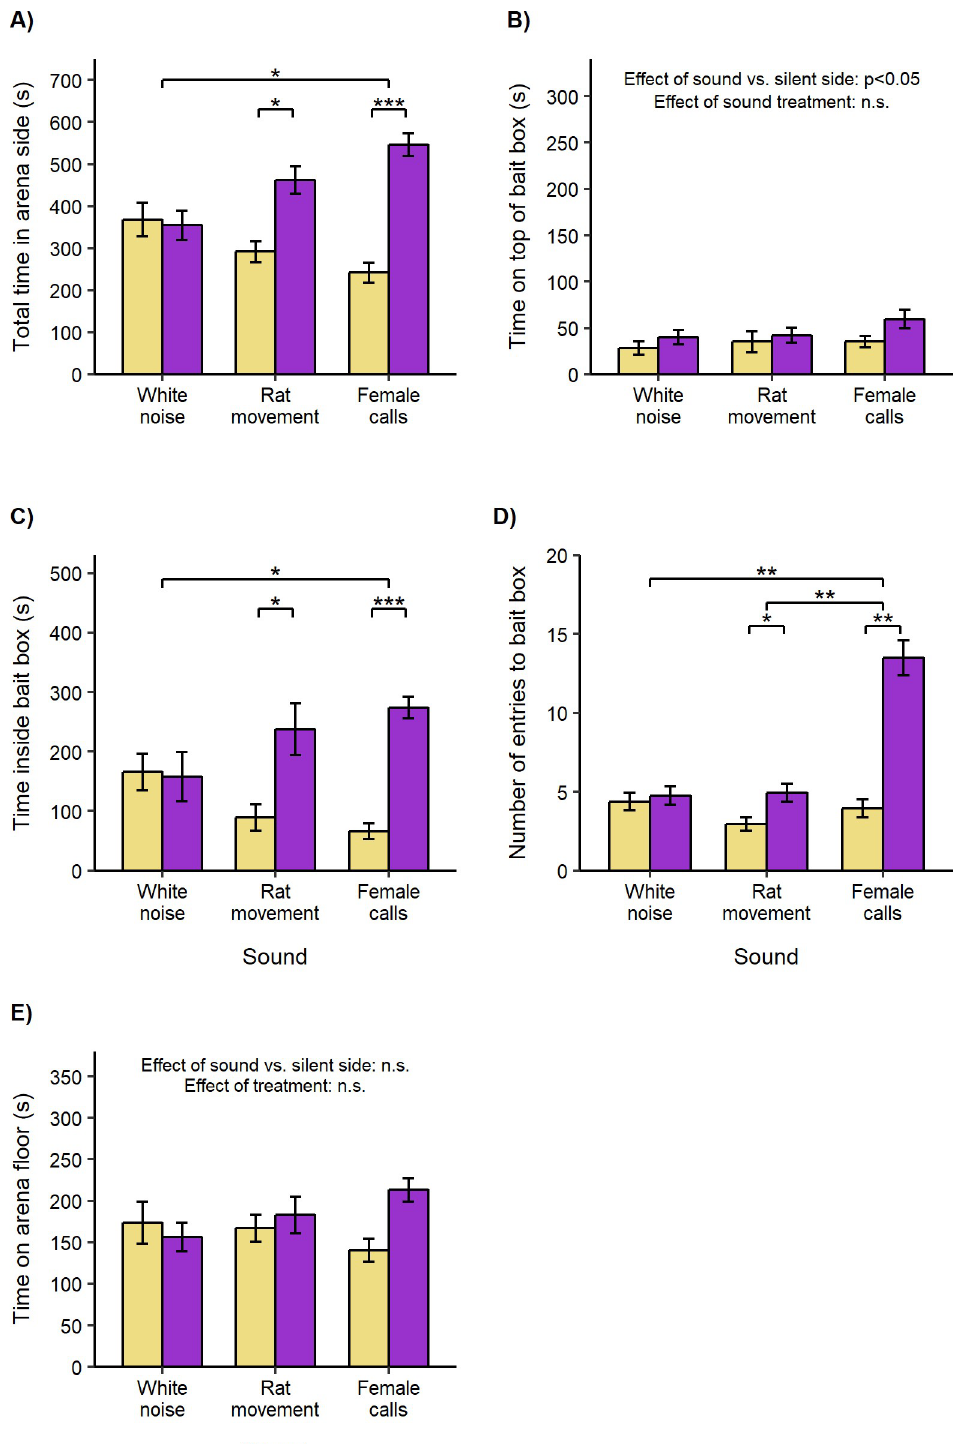
Fig 4. Attraction to rat sounds from unfamiliar donors playing inside empty bait boxes compared to white noise (mean ± standard error of mean). Adult male and female Wistar rats were presented with sound playing through a box (purple bars) versus no sound (yellow bars, control) in opposite sides of a test arena. A) Total duration in each side compartment of arena. B) Duration on top of box. C) Duration inside box. D) Number of entries to box. E) Duration on arena floor (in arena side but not in or on box). Bias between sides was compared between treatments using